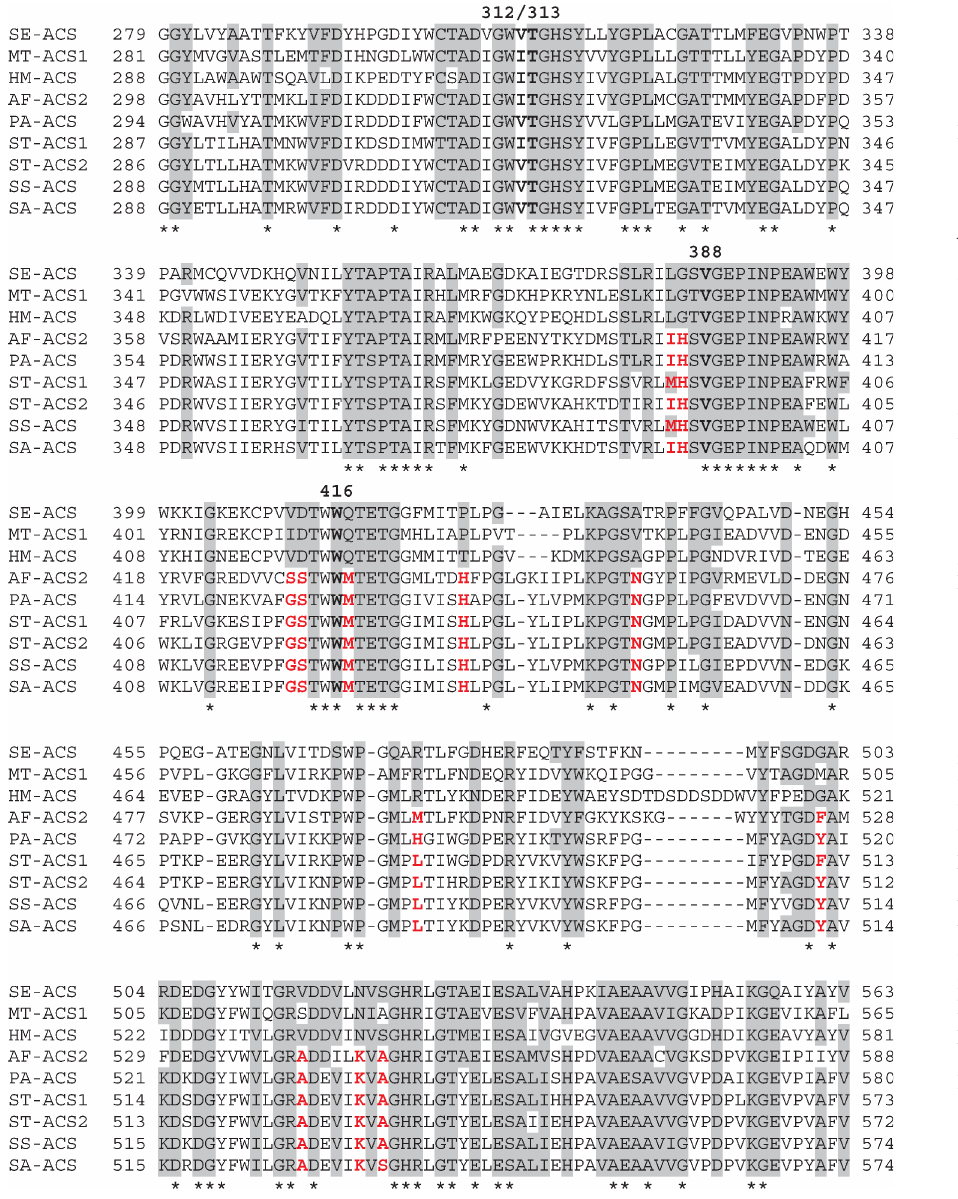
Figure 4. Alignment and ConSurf analysis of ACS se- quences. The M. thermauto- trophicus MT-ACS1 and A. fulgidus AF-ACS2 amino acid sequences were aligned with the S. enterica ACS se- quence (SE-ACS) and the ACS sequences from P. aerophilum (PA-ACS), Sulfolobus tokodaii (ST-ACS1 and ACS2), Sulfolobus solfataricus (SS- ACS), and Sulfolobus acido- caldarius (SA-ACS) using Clustal X (Thompson et al. 1997). A partial alignment is shown here. Residues of the S. enterica ACS found to have high evolutionary conservation scores by ConSurf analysis (Armon et al. 2001, Glaser et al. 2003, Landau et al. 2005) (http://consurf.tau.ac.il) are shaded, as are residues in the other ACS sequences that are identical or among the alterna- tive residues listed for each of these highly conserved posi- tions. Asterisks indicate those positions that are identical in all nine sequences. The acetate binding pocket residues are boldfaced and numbered above the aligned sequences accord- ing to their position within MT-ACS1. Those residues at positions with high ConSurf scores that differ in AF-ACS2, PA-ACS, and the Sulfolobus sequences from the three ACS sequences representing en- zymes with “traditional” char - acteristics are indicated in